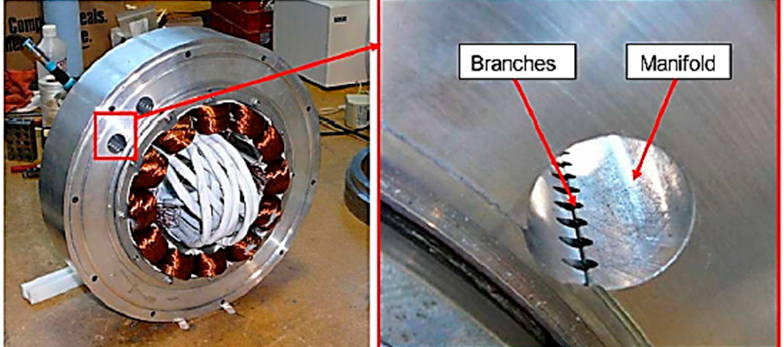
Figure 27. Stator cooling with micro channels [68].